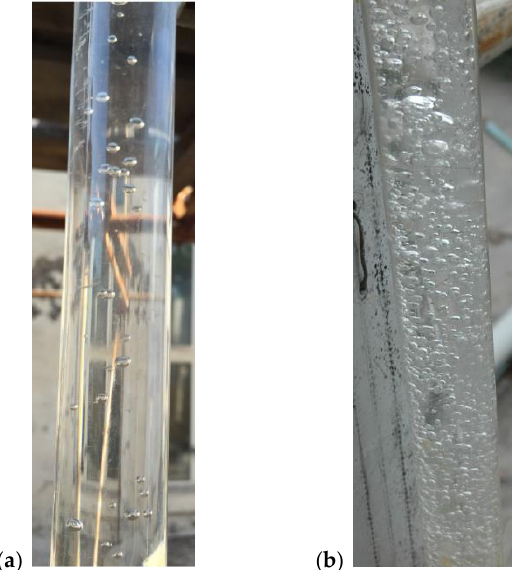
Figure 4. Flow state distribution in the fore and rear parts of the siphon pipe: ( a ) the fore part of the pipe, ( b ) the rear part of the pipe.